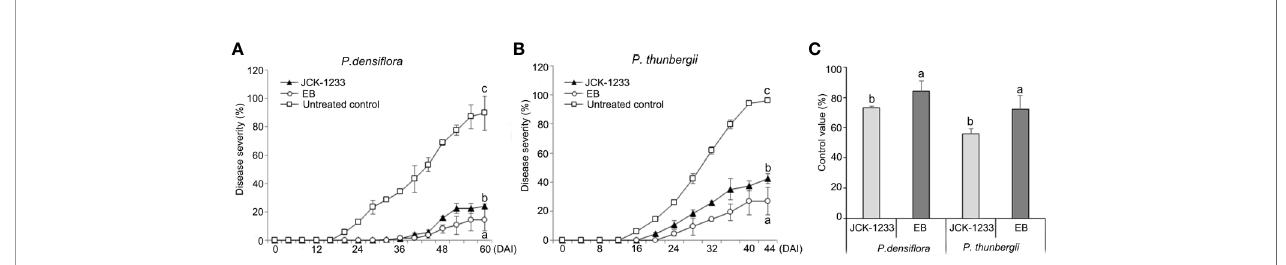
FIGURE 1 | Effect of the JCK-1233 culture broth against pine wilt disease caused by pine wood nematodes in pine seedlings. Disease severity after inoculation with pine wood nematodes in (A) red pine ( Pinus densi fl ora ) seedlings, and (B) black pine ( Pinus thunbergii ) seedlings. (C) Disease control ef fi cacy at 28 days after inoculation (DAI) in P. densi fl ora and P. thunbergii seedlings. Data was represented as the mean and standard error of two runs with fi ve replicates per run. Different lower case letters shown values that are signi fi cantly different ( p < 0.05) level by Duncan ’ s test.